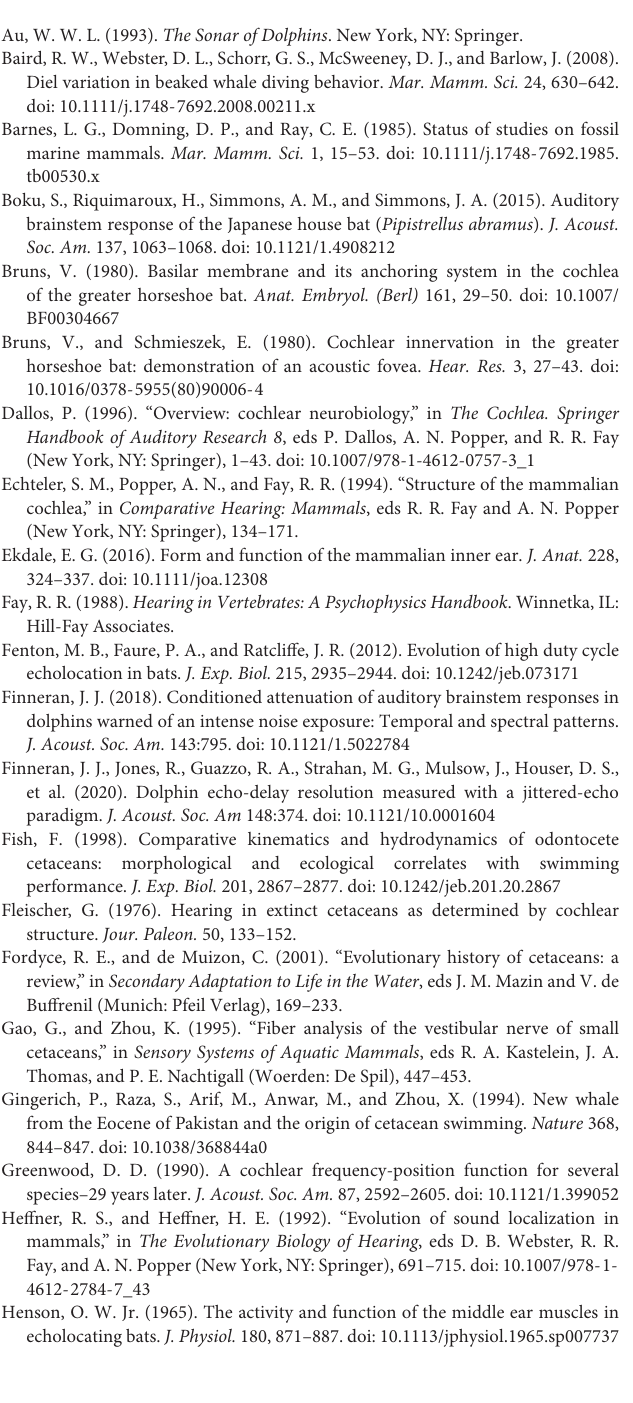
The capsule fades as the inner ear rotates, revealing the path and profile of the basilar membrane (green) within inner ear labyrinth (see Figure 6 for dimensions and detail of the